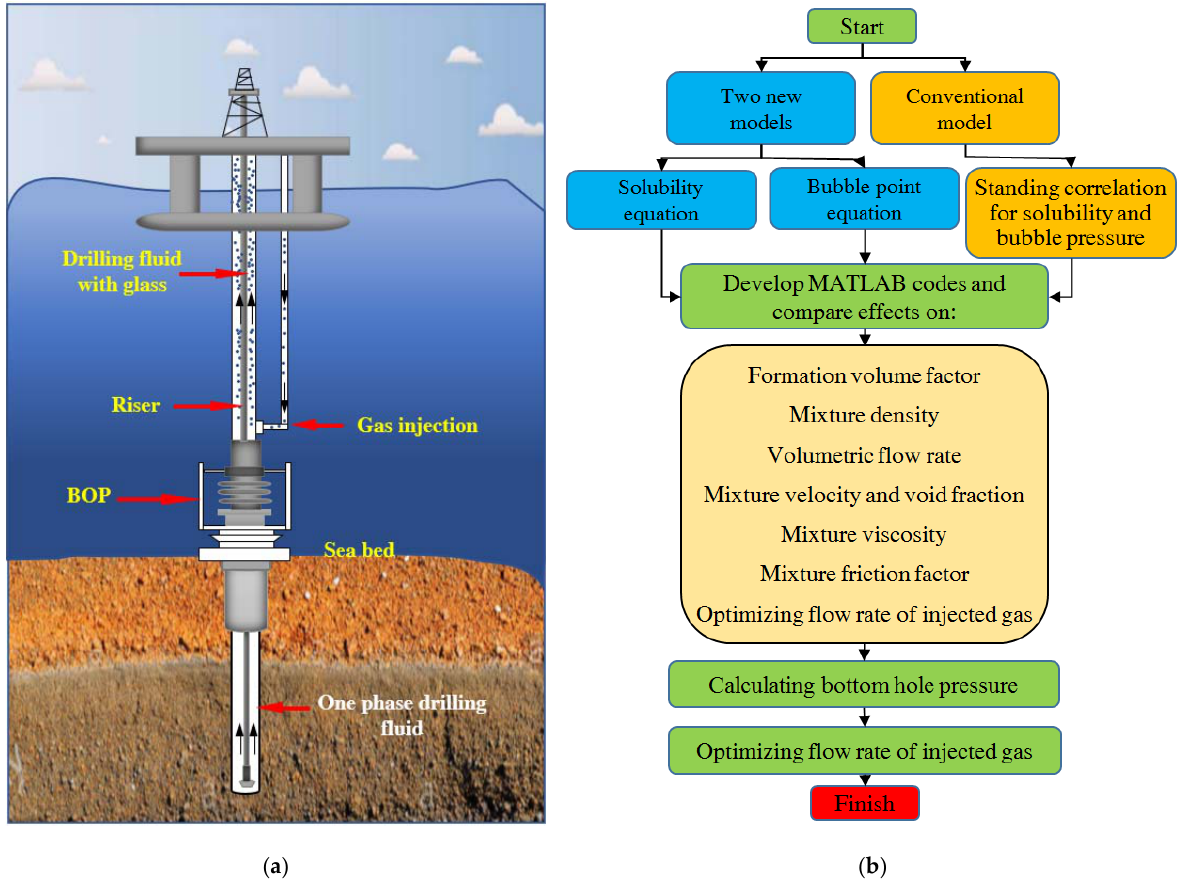
Figure 3. ( a ) Schematic representation of the gas-lift DGD, ( b ) Workflow of the current research.